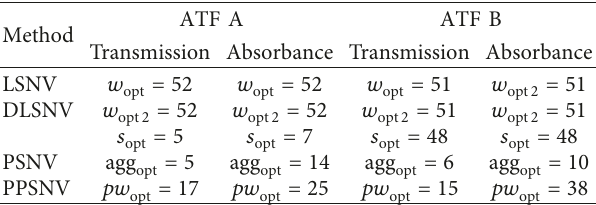
Figure 12: RMSE as a function of the noise level factor for the regression of the antioxidant compound of ATF B calibrated by the original full data set. The error bars represent the standard deviation of the prediction error calculated from the statistics of 50 repetitions of noise addition. In subplot (a) all curves are shown, and in (b), the sophisticated standardizations are shown. Table 3: Summary of the preprocessing parameters. For DLSNV window size and starting point, for PSN agglomeration window, and for PPSNV, window width around POI is